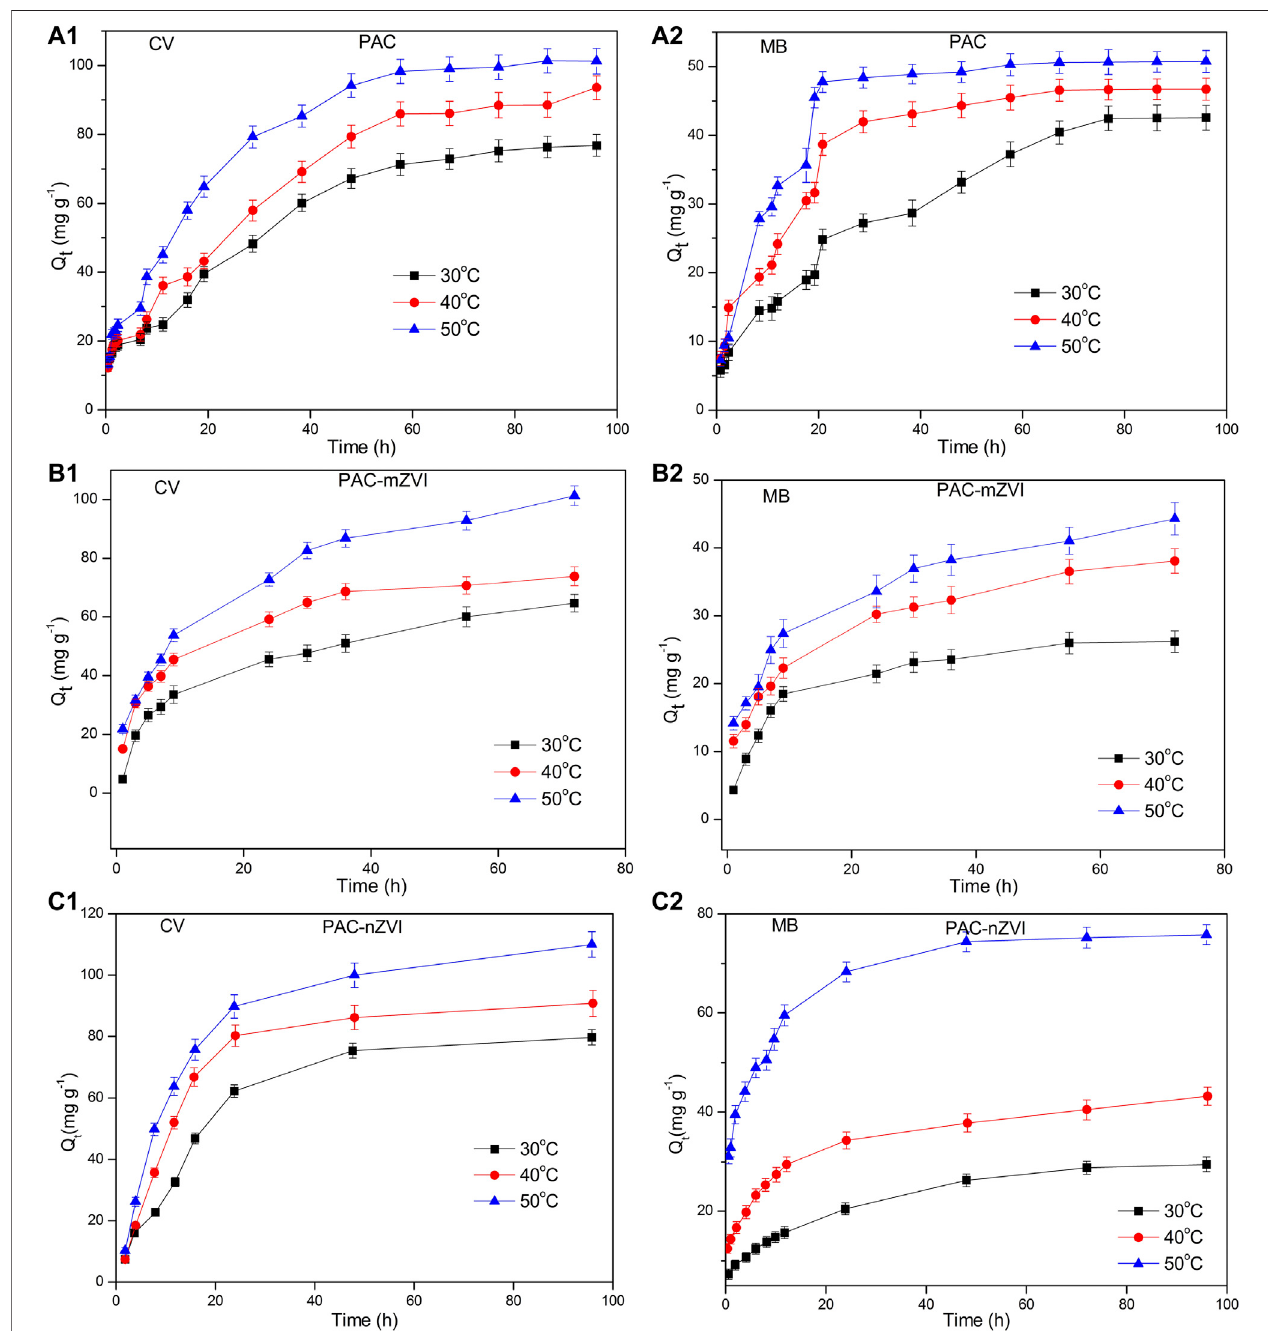
FIGURE 6 | Effects of temperature on the removal of CV and MB by PAC, PAC-mZVI, and PAC-nZVI adsorbents.